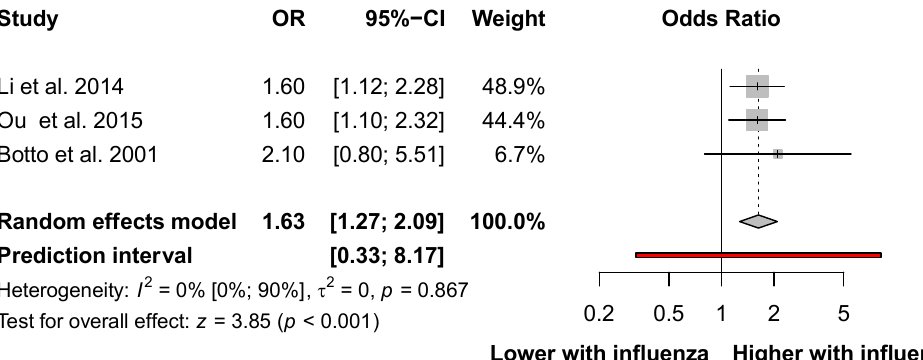
Figure 5. Adjusted odds ratio of developing congenital heart defects after influenza infection in the first trimester [8,32,37].